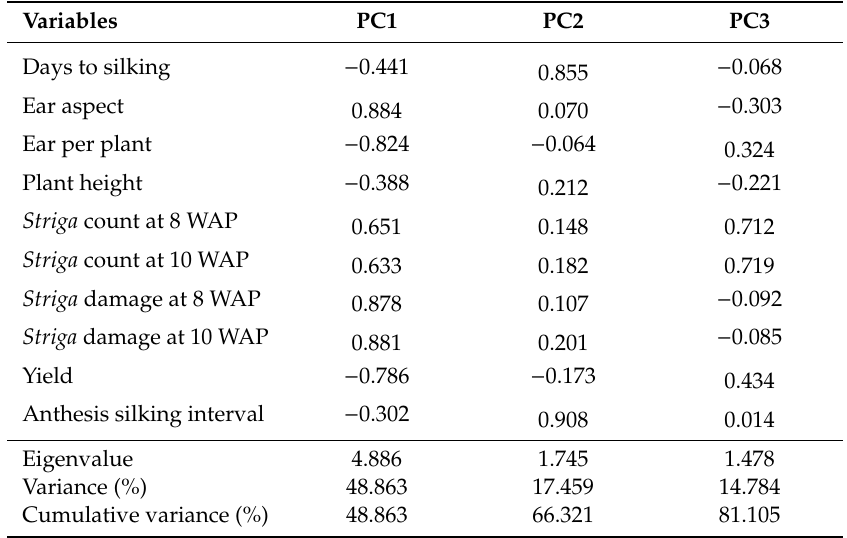
Table 2. Principal component analysis and variables contributing the most under Striga infestation.